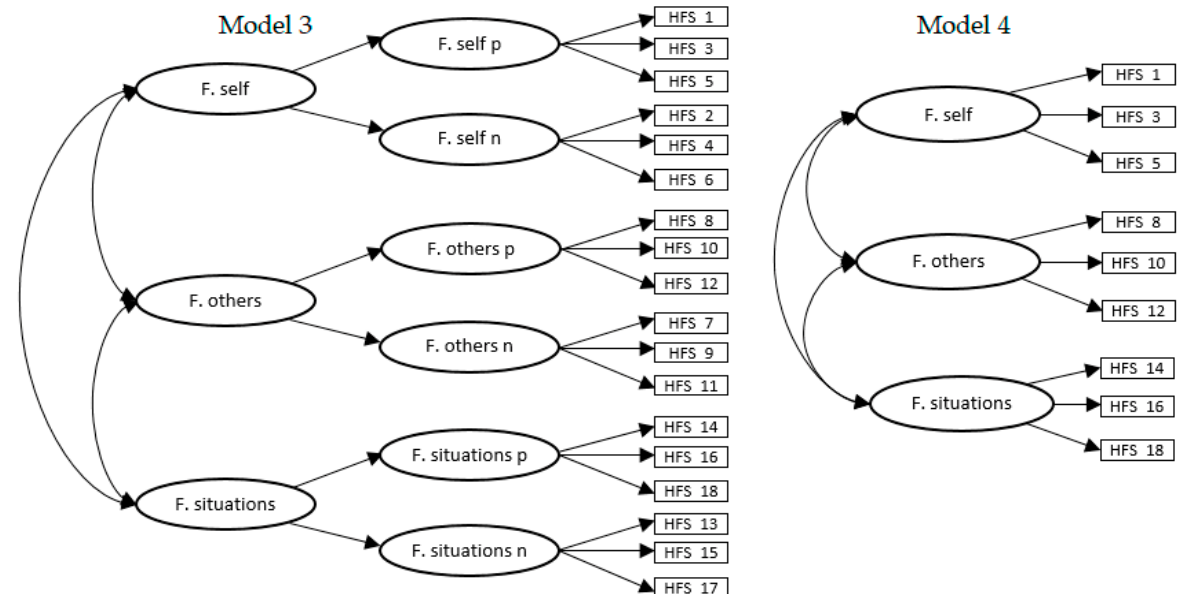
Figure 2. Model 3 and model 4. F. self = forgiveness of self; F. others = forgiveness of others; F. situations = forgiveness of situations; p = positively worded items; n = negatively worded items.